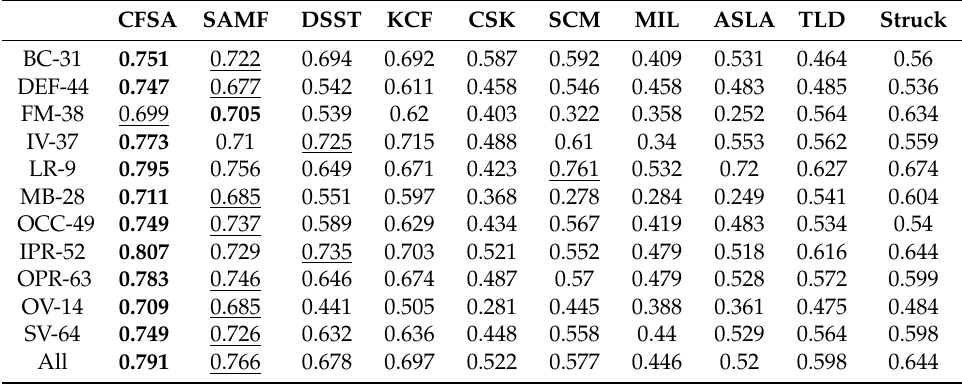
Table 3. The precision scores of CFSA tracker and nine other trackers at the center location error threshold = 20 pixels on the OTB-100 dataset. Bold and underline values indicate best and second performances,